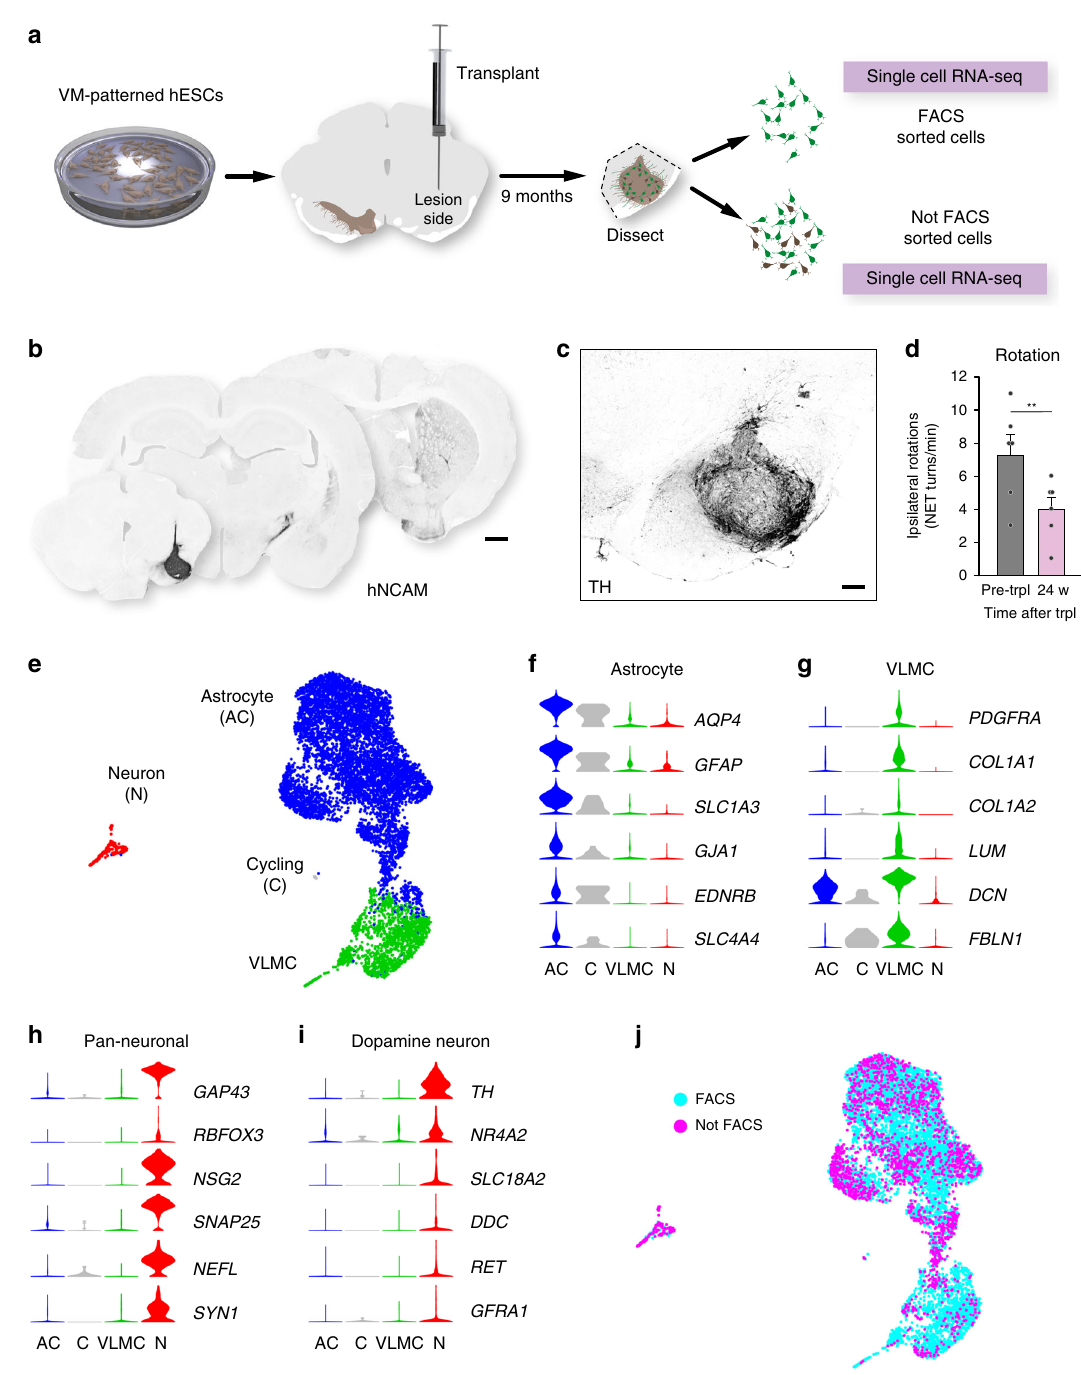
Fig. 4 scRNA-seq analysis and histological validation of grafted cells into the midbrain. a Schematic overview of experimental design. VM-patterned hESCs grafted to midbrain of 6-OHDA rats and analyzed at 9 months (n = 6). These rats were used as follows: scRNA-seq n = 3; histology n = 3, functional recovery n = 6. b Overview of hNCAM fi ber outgrowth from hESC-derived intranigral graft showing a neuron-rich graft core and extensive re-innervation of the host striatum. c Immunohistochemistry showing TH staining in graft core of a hESC-derived intranigral graft at 9 months post- transplantation. d Drug-induced rotation test showing functional recovery in rats that have been transplanted to the midbrain with hESC-derived cells ( n = 6 rats; mean ± SEM; ** p < 0.01; compared to post-lesion; two-tailed paired t -test). e UMAP embedding showing clustering of 7875 analyzed cells after grafting to the midbrain (grafted rats n = 3). f – i Expression level per cluster for indicated genes. Indicated genes are established markers for astrocytes, VLMCs, neurons, and DA neurons, respectively. All indicated markers are the same as in Fig. 2. j UMAP of grafted cells as shown in Fig. 4e. Cells isolated by FACS (blue circles, n = 5958) or not by FACS (magenta circles, n = 1917) are indicated. Scale bars, 1 mm ( b ); 200 µ M ( c